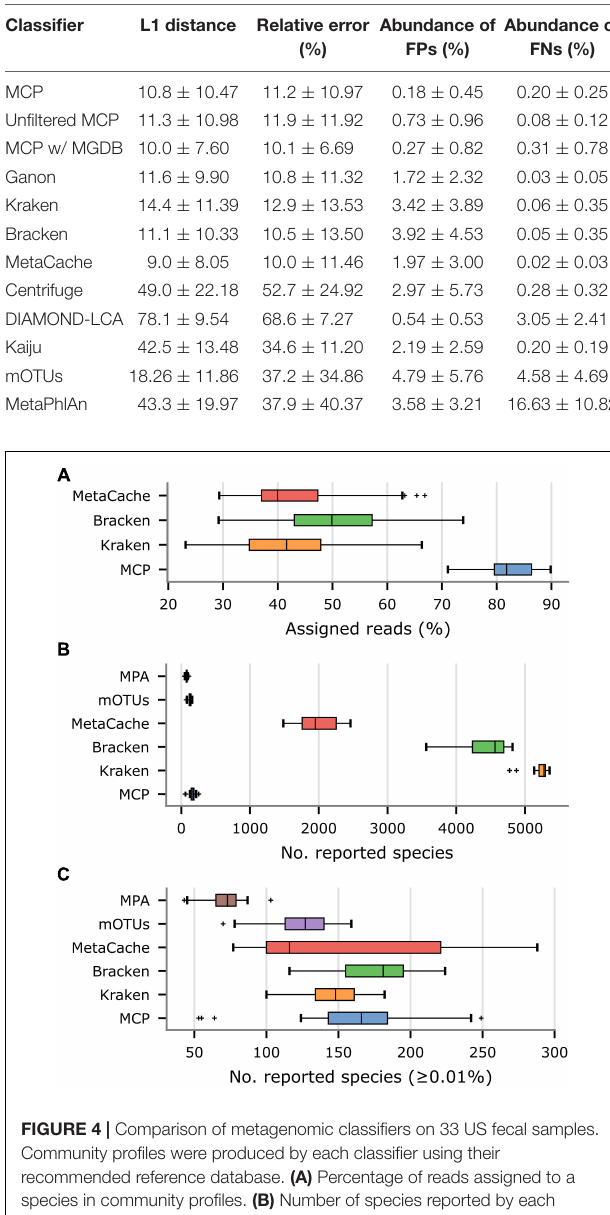
TABLE 5 | Performance statistics for species abundance estimates across the 140 mock communities (mean ± std. dev.).